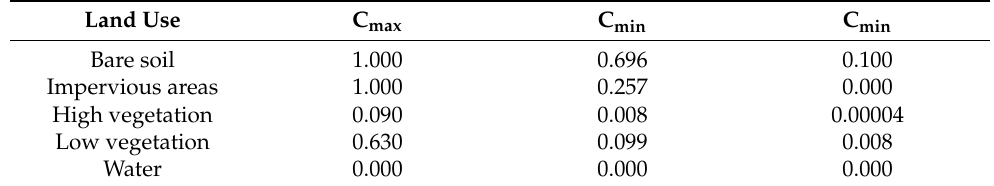
Table 3. C-factor values for five land-use/land-cover (LULC) classes in Brazil from a literature review by